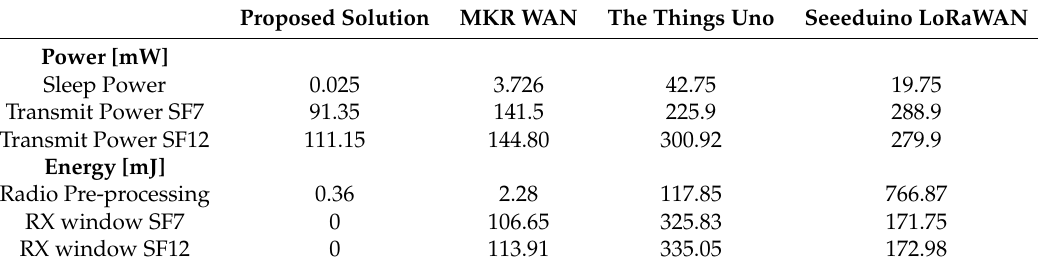
Table 4. Power consumption of the considered